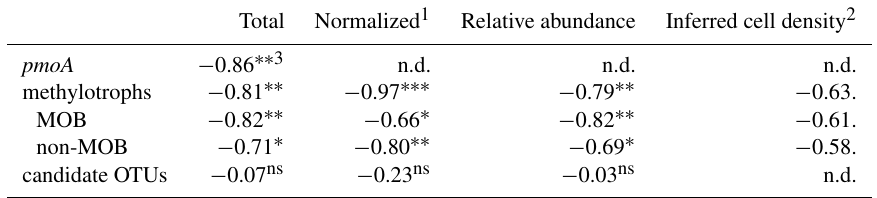
Table 5. Spearman rank order correlations coefficients ( ρ S ) of k ox vs. the number of sequences of pmoA, MOB and non-MOB methylotrophs, and candidate OTUs. Candidate OTUs are OTUs that were differentially more abundant in 10 × and 200 × incubated